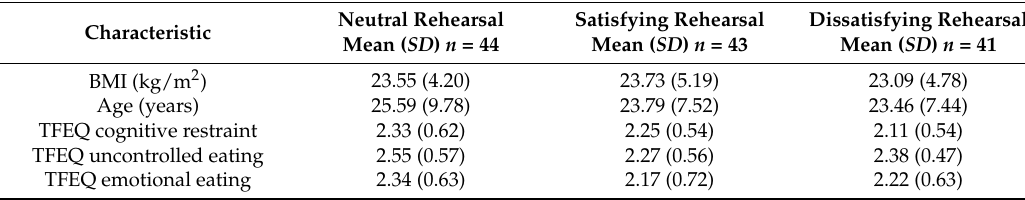
Table 1. Sample characteristics as a function of rehearsal